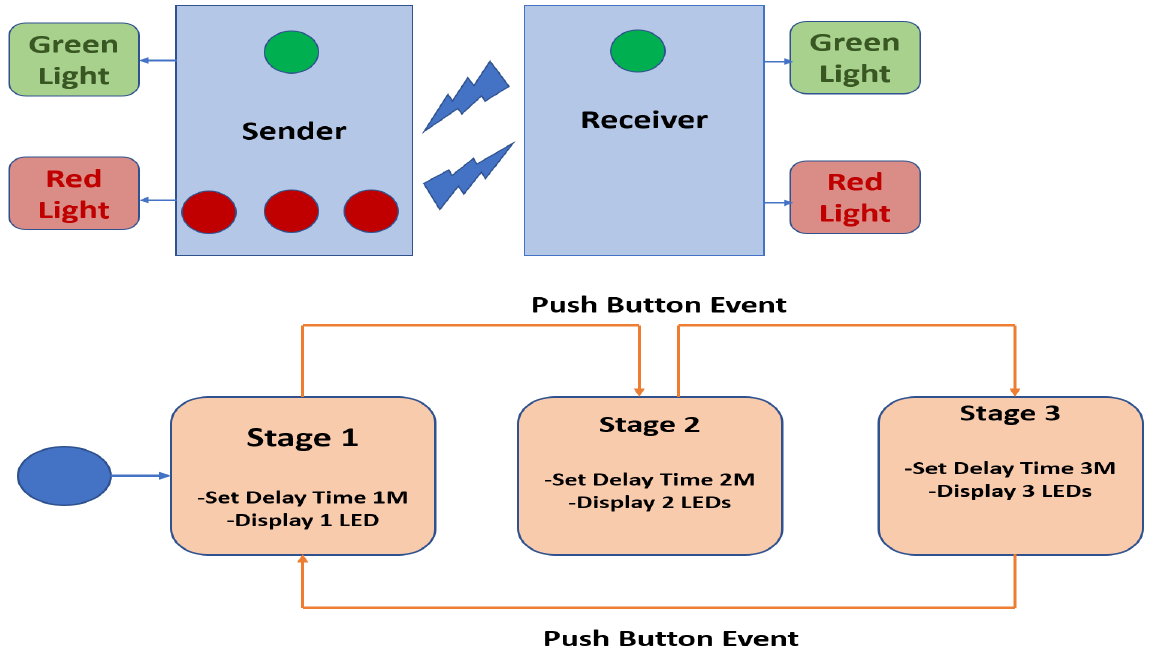
Figure 4. Overview of Single-lane traffic control using NodeMCU V.2 [67] .